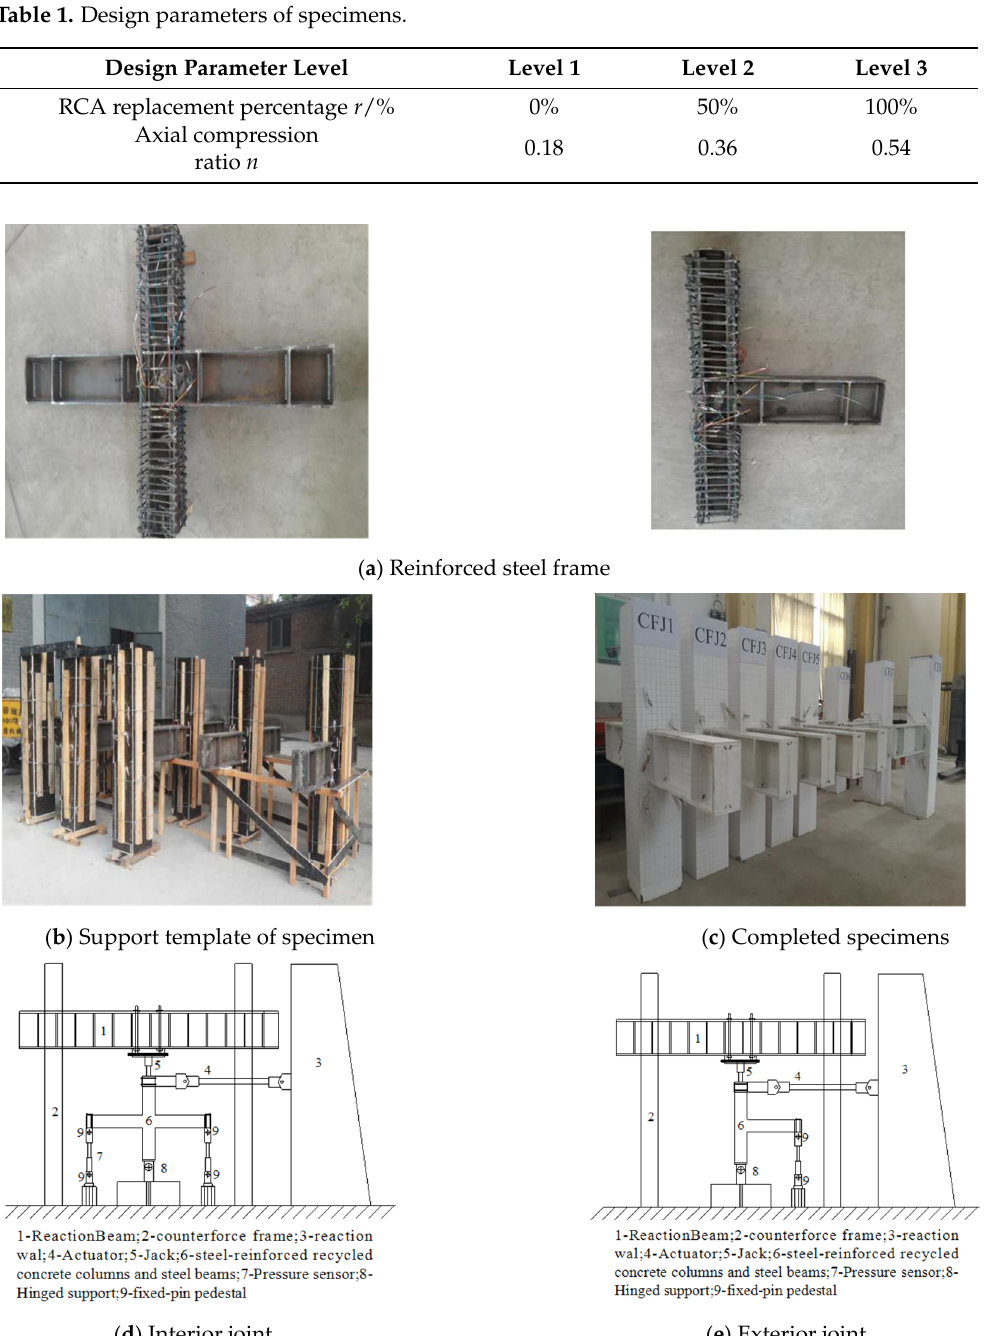
Table 1. Design parameters of specimens.